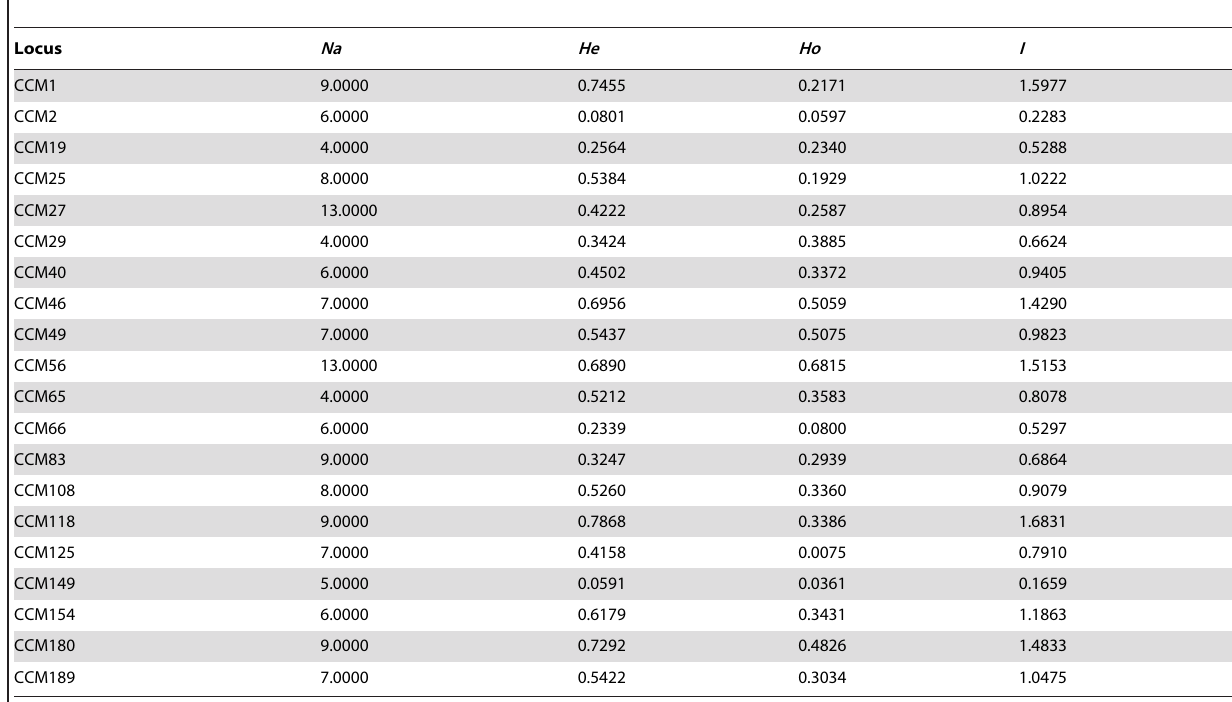
Table 8. Informativeness of SSR loci following amplification from 18 geographically diverse Callosobruchus chinensis populations in China.